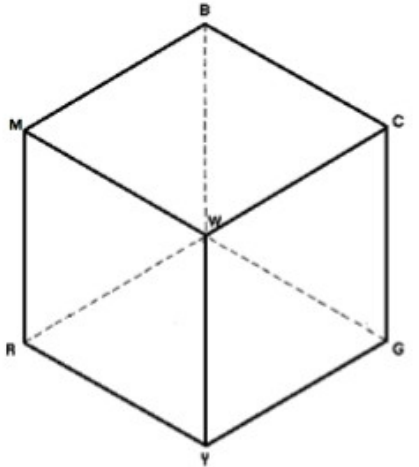
Figure 6: Hexagonal projection of HSV colour space. (Adapted from Smith 30 ) The solid lines show the RGB cube in the orienta- tion needed to visualize the HSV